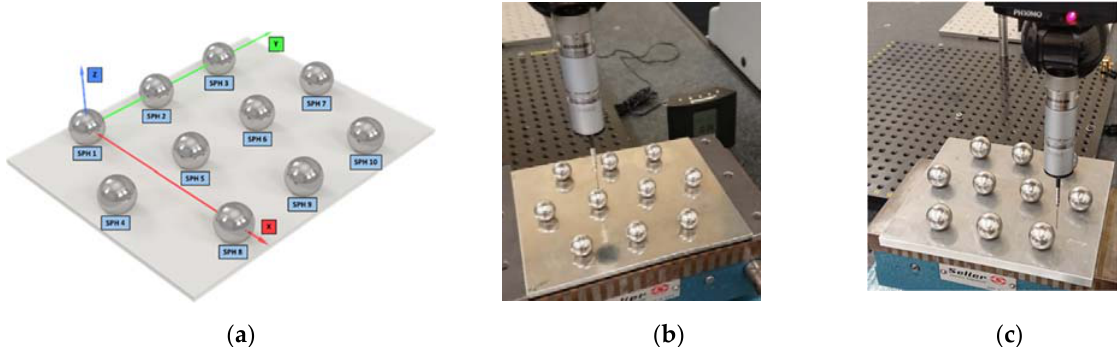
Figure 3. Plate with 10 spheres of the same diameter: ( a ) designation of the spheres and reference system; ( b ) CMM contact measurement of a set of ten spheres (25 mm diameter) on the original base plate; ( c ) CMM contact measurement of a sandblasted base plate.